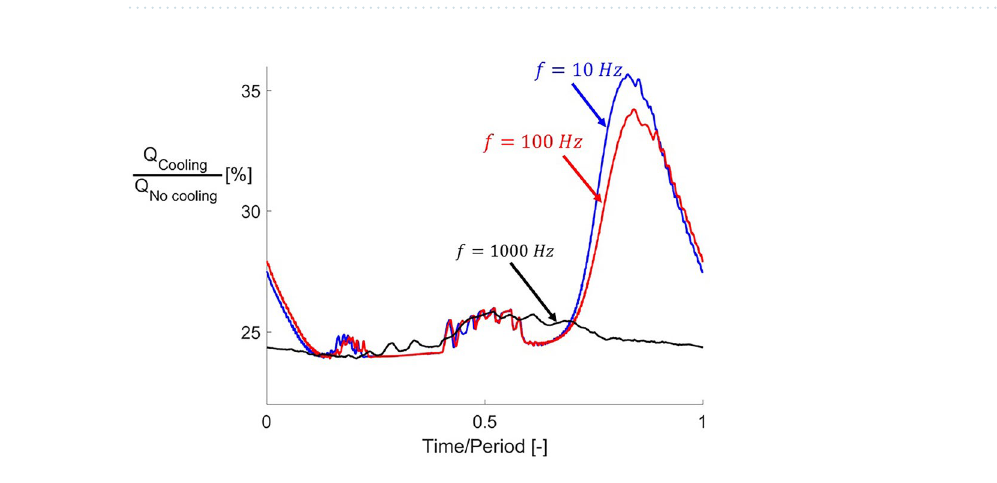
Figure 21. Bow shock distance from leading edge evolutions with respect to time for three different cooling total pressure fluctuation frequencies.